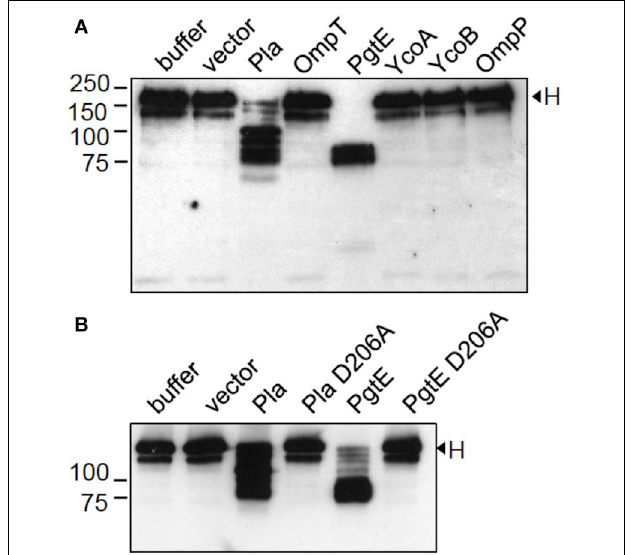
FIGURE 3 | Cleavage of factor H by E. coli expressing omptin proteins. (A) E. coli 83972 (cid:2) ompT bacteria expressing omptin proteins or the empty vector were incubated with purified H (33 μ g/ml) for 4h. (B) E. coli XL1 bacteria expressing Pla, PgtE, their D206A-mutants or the empty vector were incubated with H for 1h. The supernatants were run in SDS-PAGE under reducing conditions and immunoblotted with a polyclonal anti-H antibody. Samples of H incubated in buffer are shown for comparison. The assays were conducted at least twice with consistent results.